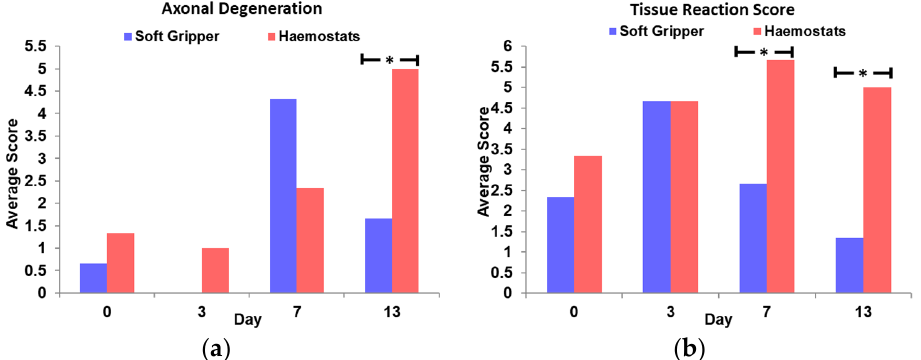
Figure 7. The average score of ( a ) axonal degeneration and ( b ) tissue reaction score across different time-points (* means p < 0.05).